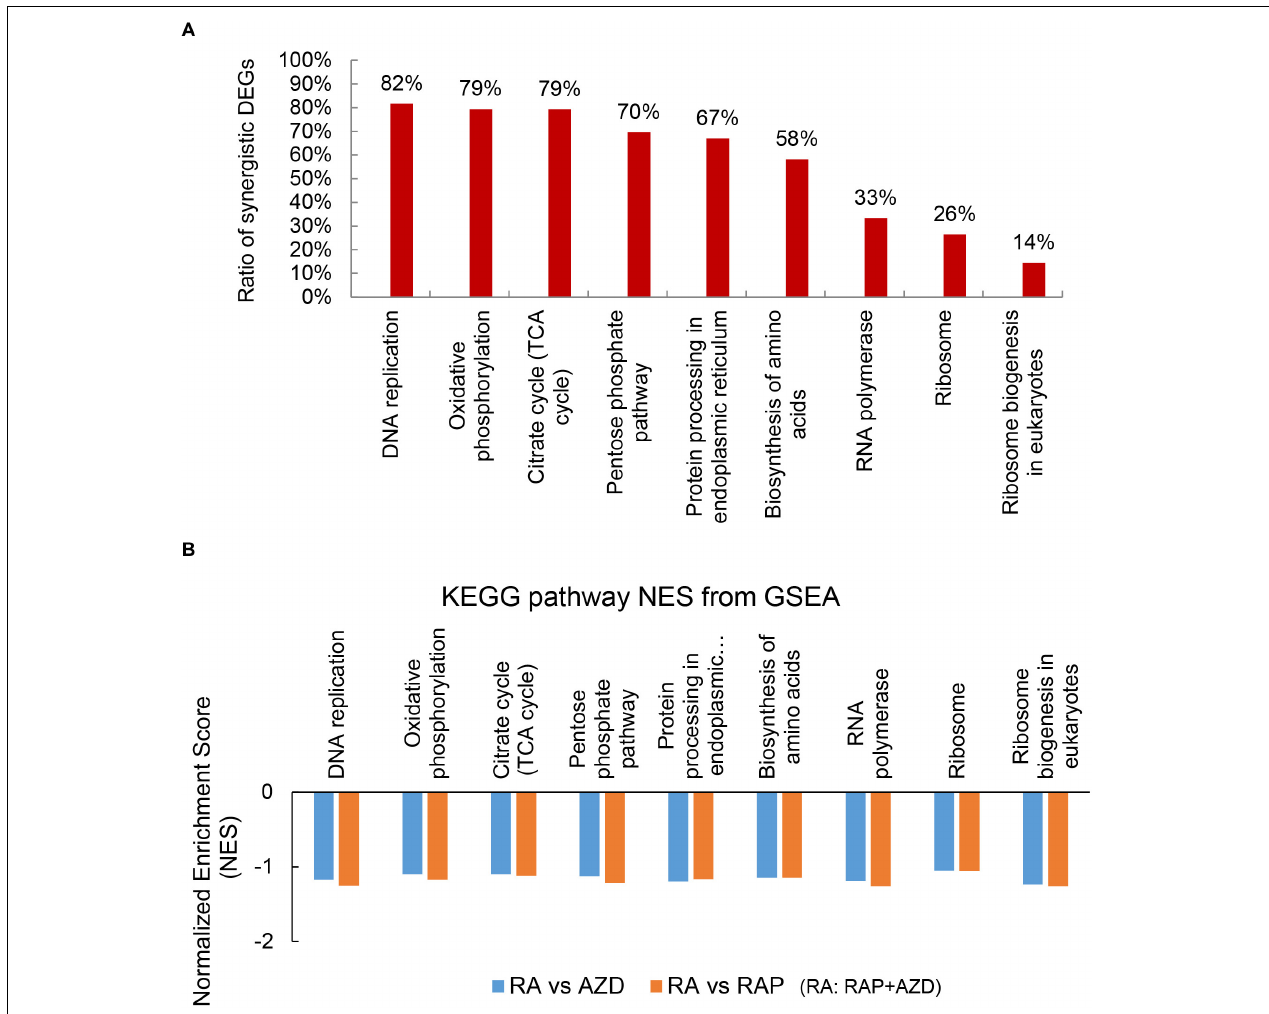
FIGURE 7 | Synergistic DEGs and gene expression trends in nine co-existing KEGG pathways after treatment with RAP + AZD. (A) Ratio of synergistic DEGs in the nine co-existing KEGG pathways. Ratio of synergistic DEGs = synergistic DEGs/total DEGs. (B) GSEA analyses of genesets for nine co-existing KEGG pathways. NES, normalized enrichment score. FDR, false discovery rate. Negative (–) and Positive (+) NES indicate down-regulated and up-regulated expression in RAP + AZD, respectively. All the FDR of nine co-existing KEGG pathways < 0.25.